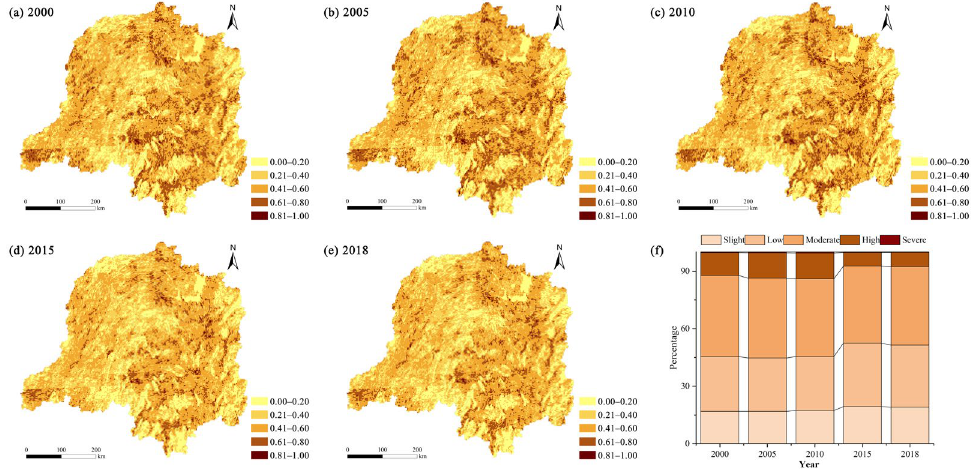
Figure 2. Distribution of spatial conflict of PLES in Dongting Lake Basin from 2000 to 2018: ( a – e ) spatial conflict distribution, and ( f ) spatial conflict level proportions.